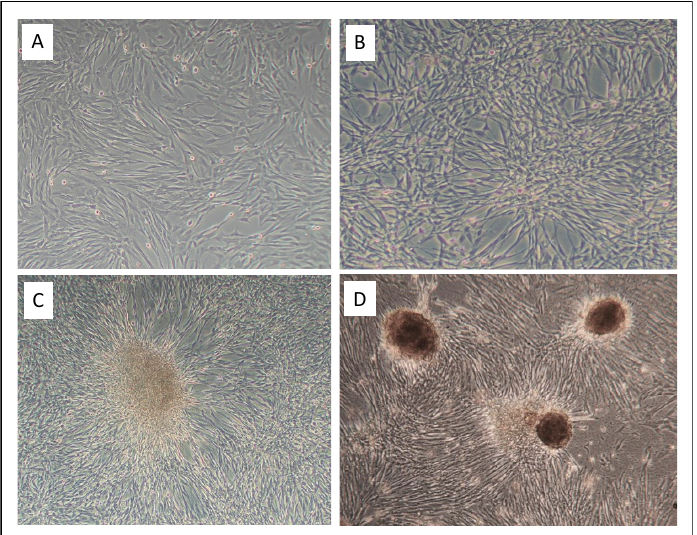
Figure 1. BPV1- and 2-infected fibroblasts lose contact inhibition and form aggregates. ( A ): non- infected equine primary fibroblasts (ArcA) in passage 3 (P3): the cells display the typical flat, elon- gated, spindle-shaped morphology of normal fibroblasts. ( B ): loss of contact inhibition in BPV1- infected equine fibroblasts in P3: cells begin to aggregate and pile up. C and D: BPV1- ( C ) and BPV2- infected equine fibroblasts ( D ) form dense three-dimensional cell aggregates consistent with tumor cell spheres. These events were documented by inverse phase-contrast microscopy (Axiovert 40 CFL, Zeiss, Jena, Germany) at 50× and 100× magnification.